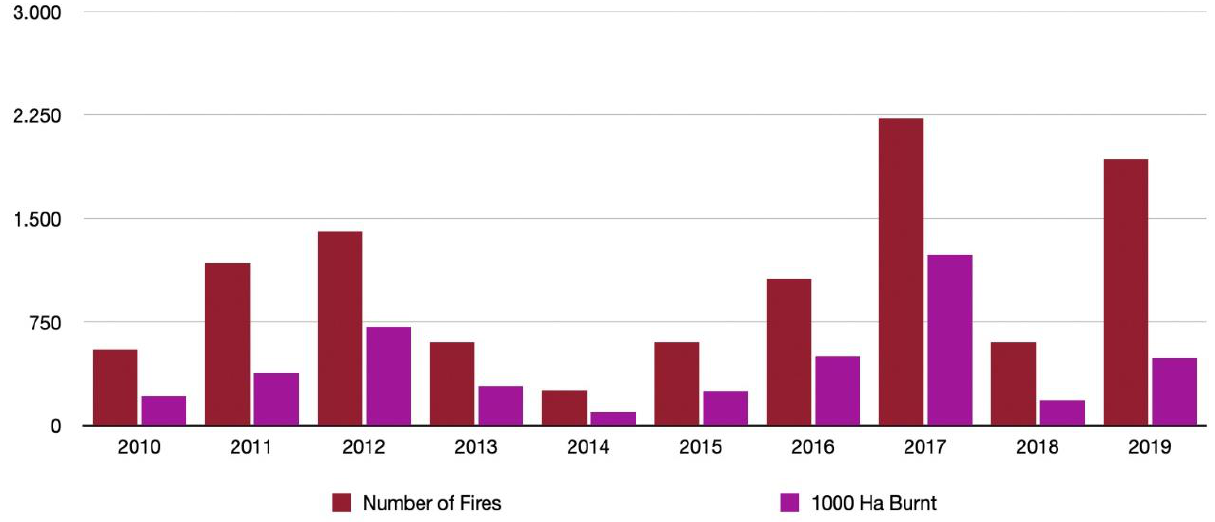
Figure 1. Forest fires above 50 hectares recorded in Europe from 2010 to 2019. Source: EFFIS, 2020.